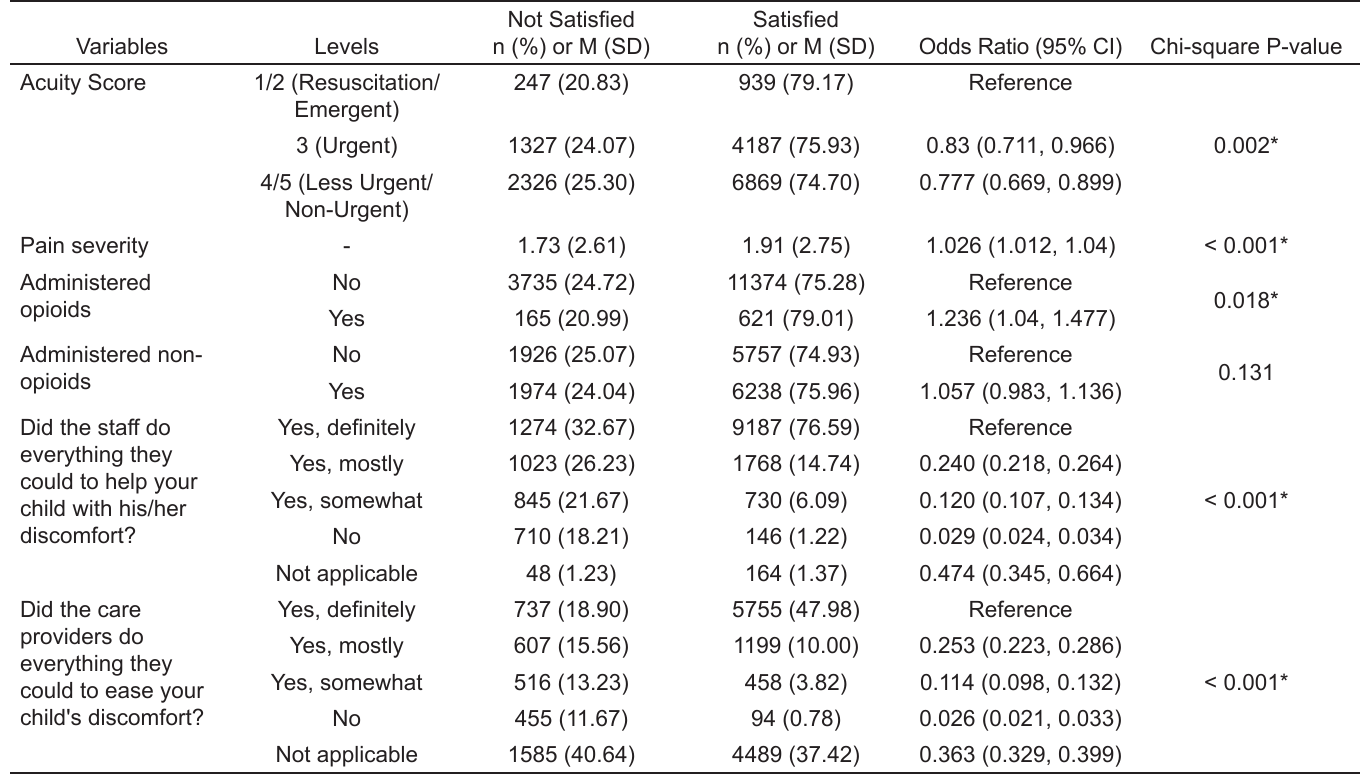
Table 2. Results of bivariate analysis.